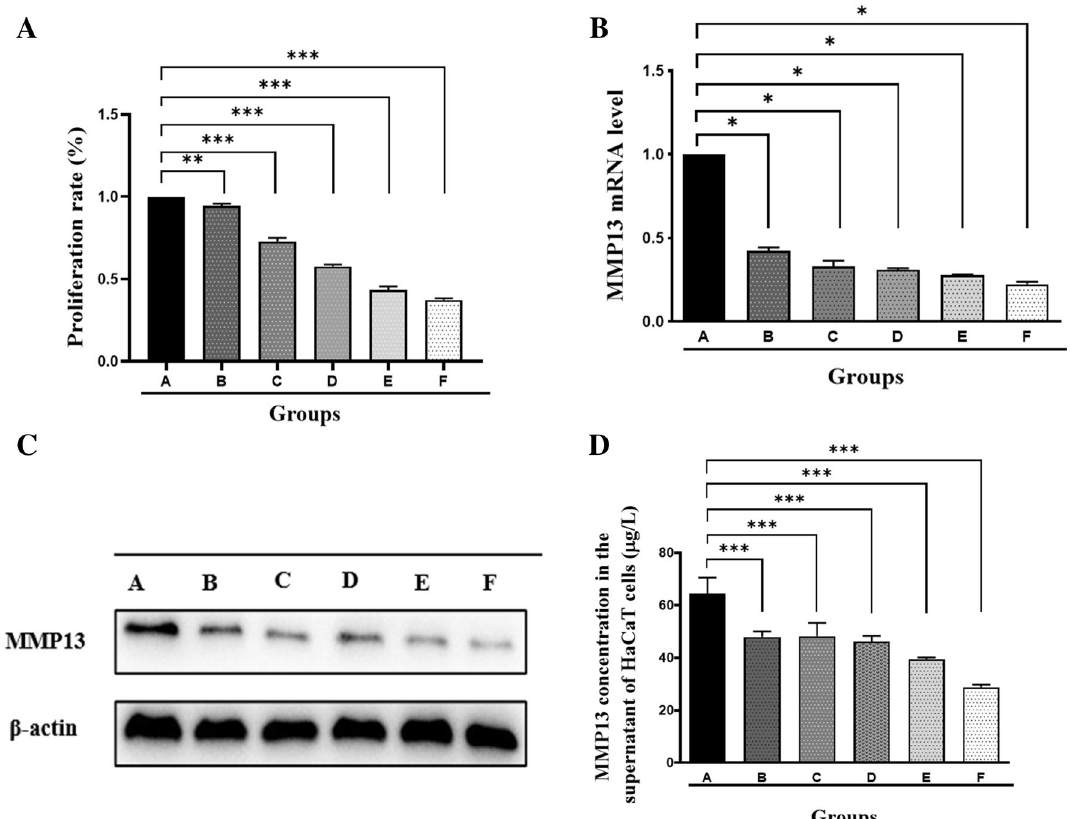
Figure 3. Effects of acitretin treatment or NB-UVB irradiation on HaCaT cells. Groups A–F: control, 1 µM acitretin, 50 mJ/cm 2 NB-UVB, 1 µM acitretin + 50 mJ/cm 2 NB-UVB, 100 mJ/cm 2 NB-UVB, and 1 µM acitretin + 100 mJ/cm 2 NB-UVB, respectively. ( A ) Analysis of HaCaT cell proliferation rate after indicated treatments. ( B ) Analysis of MMP13 mRNA levels in HaCaT cells treated as in ( A ). ( C ) Western blot analysis of MMP13 protein levels in HaCaT cells after indicated treatments. ( D ) Elisa analysis of MMP13 concentration in the supernatant of HaCaT cell. Data represent the mean ± standard deviation. relative to control group. The data were analyzed with one-way ANOVA with Dunnett’s multiple